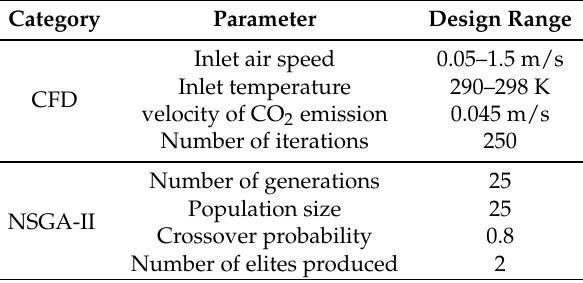
Table 2. Main parameters of the optimization case. NSGA-II: non-dominated-and-crowding Sorting Genetic Algorithm